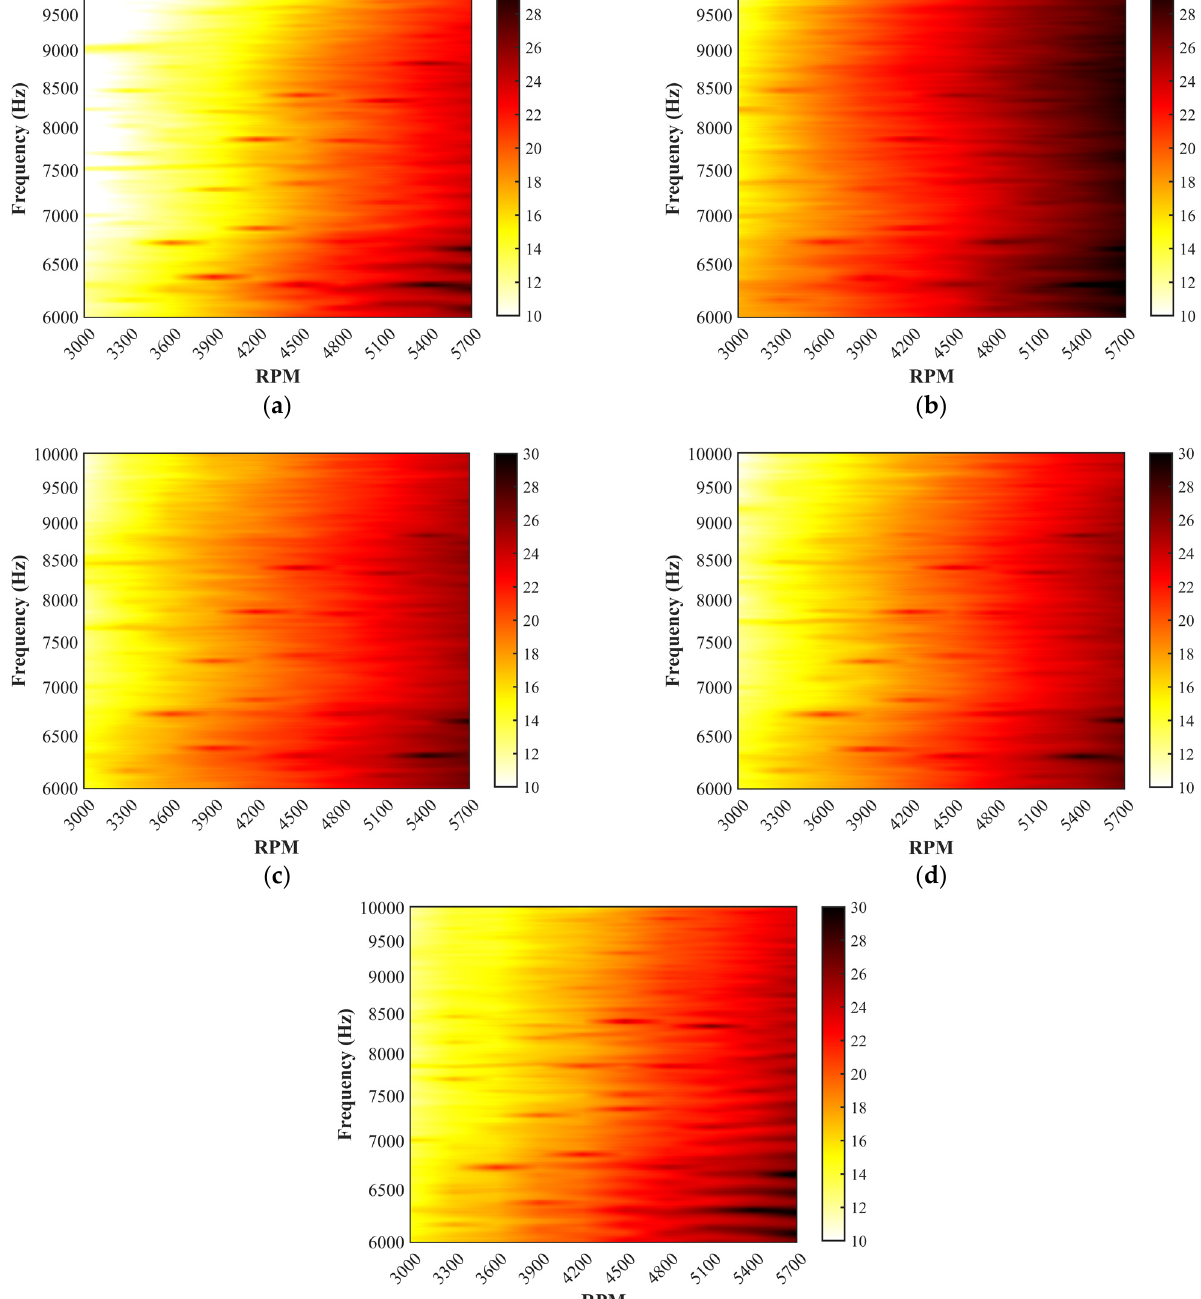
Figure 10. Contour maps of the SPL in dB ( 𝑀𝑖𝑐 2,𝜃 = 25 deg ) over a frequency range of 6000–10,000 Hz associated with propeller noises: ( a ) two-blade propeller (#1), ( b ) four-blade propeller (#2), ( c ) loop-type propeller (#3), ( d ) wide chord loop-type propeller (#4), and ( e ) DJI Phantom propeller (#5) at various rotational speeds.